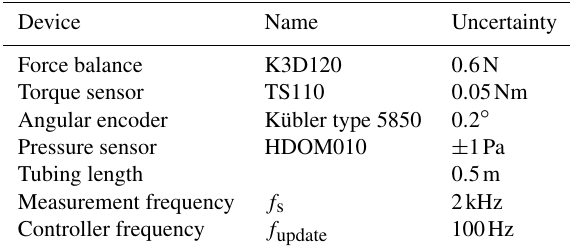
and one on the bottom of the airfoil, and a torsion sensor type TS110 (ME-Meßsysteme).